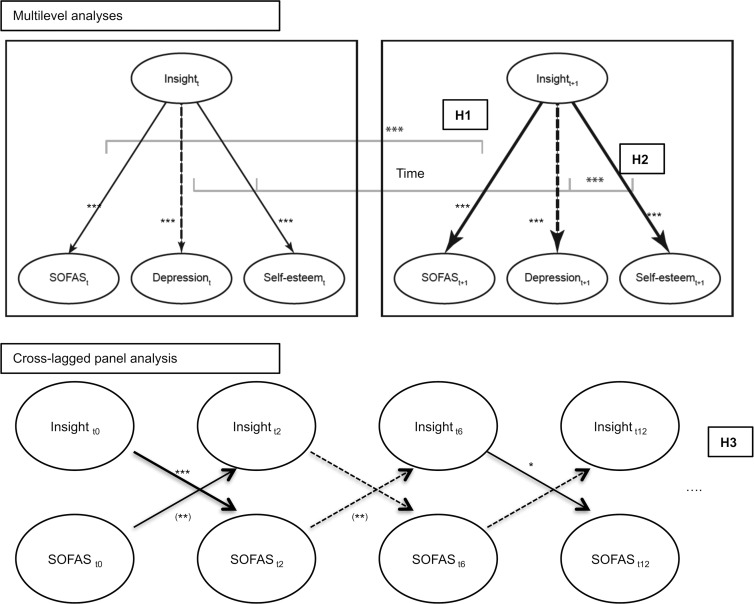
Schematic representation of the estimated relations between Insight, SOFAS, depressive symptoms and Self-esteem obtained from the multilevel and cross-lagged panel analyses. Continuous lines indicate a positive coefficient and dotted lines indicate a negative coefficient: *** p < 0.001; ** p < 0.01; * p < 0.05. Subscripts designate time points. H1, H2, H3 refer to the hypotheses: H1, positive effect of insight on SOFAS would increase with time; H2, negative effect of insight on depressive symptoms and positive effect of insight on self-esteem would increase with time; H3, insight at tx would have a positive effect on SOFAS at tx+1.